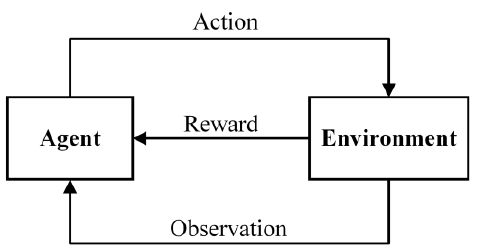
Figure 4. Reinforcement learning model.